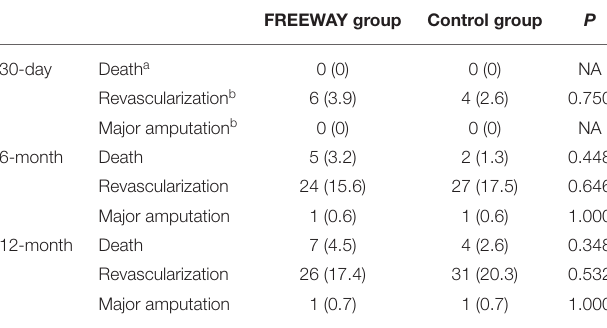
TABLE 5 | Summary of major adverse events at follow up.